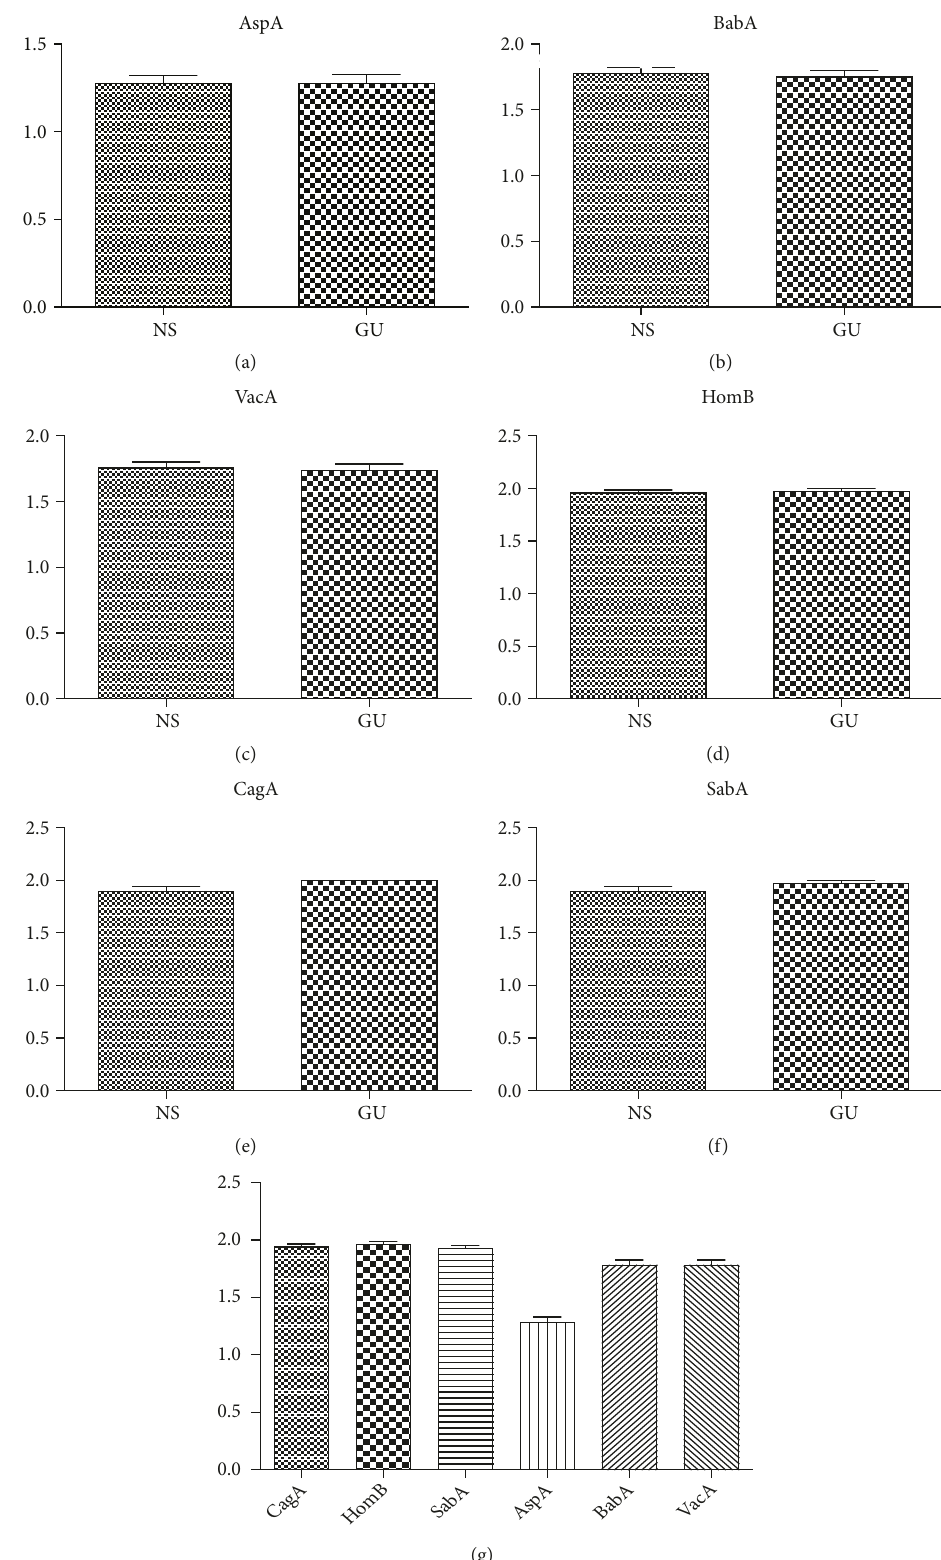
Figure 2: PCR application of the biopsy samples taken from H. pylori positive patients with nonulcerand gastric ulcer samples. The presence of AspA (a), BabA (b), VacA (c), HomB (d), CagA (e), and SabA (f) genes in nonulcer and gastric ulcer samples by using PCR. (g) The comparison of H. pylori virulence factors in normal and gastric ulcer